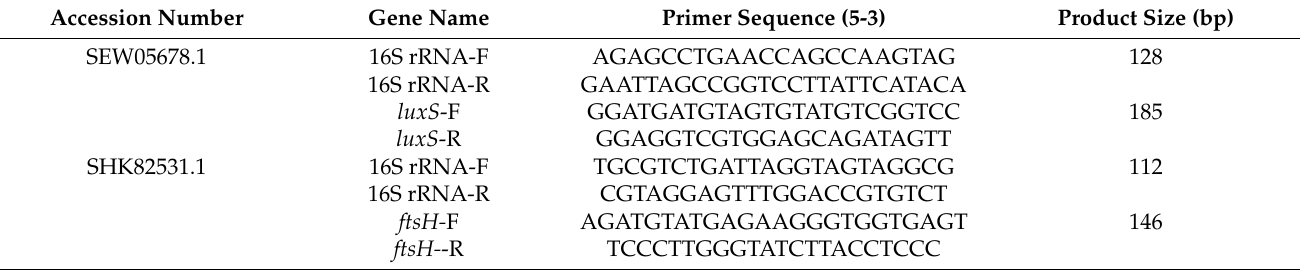
Table 2. Primers designed for gene expressions of LuxS/AI-2 quorum sensing and biofilm